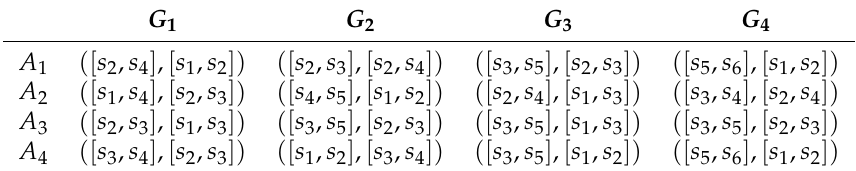
Table 3. Linguistic interval-valued intuitionistic fuzzy decision matrix (cid:101) R ( 3 ) of decision-maker D ( 3 ) . G